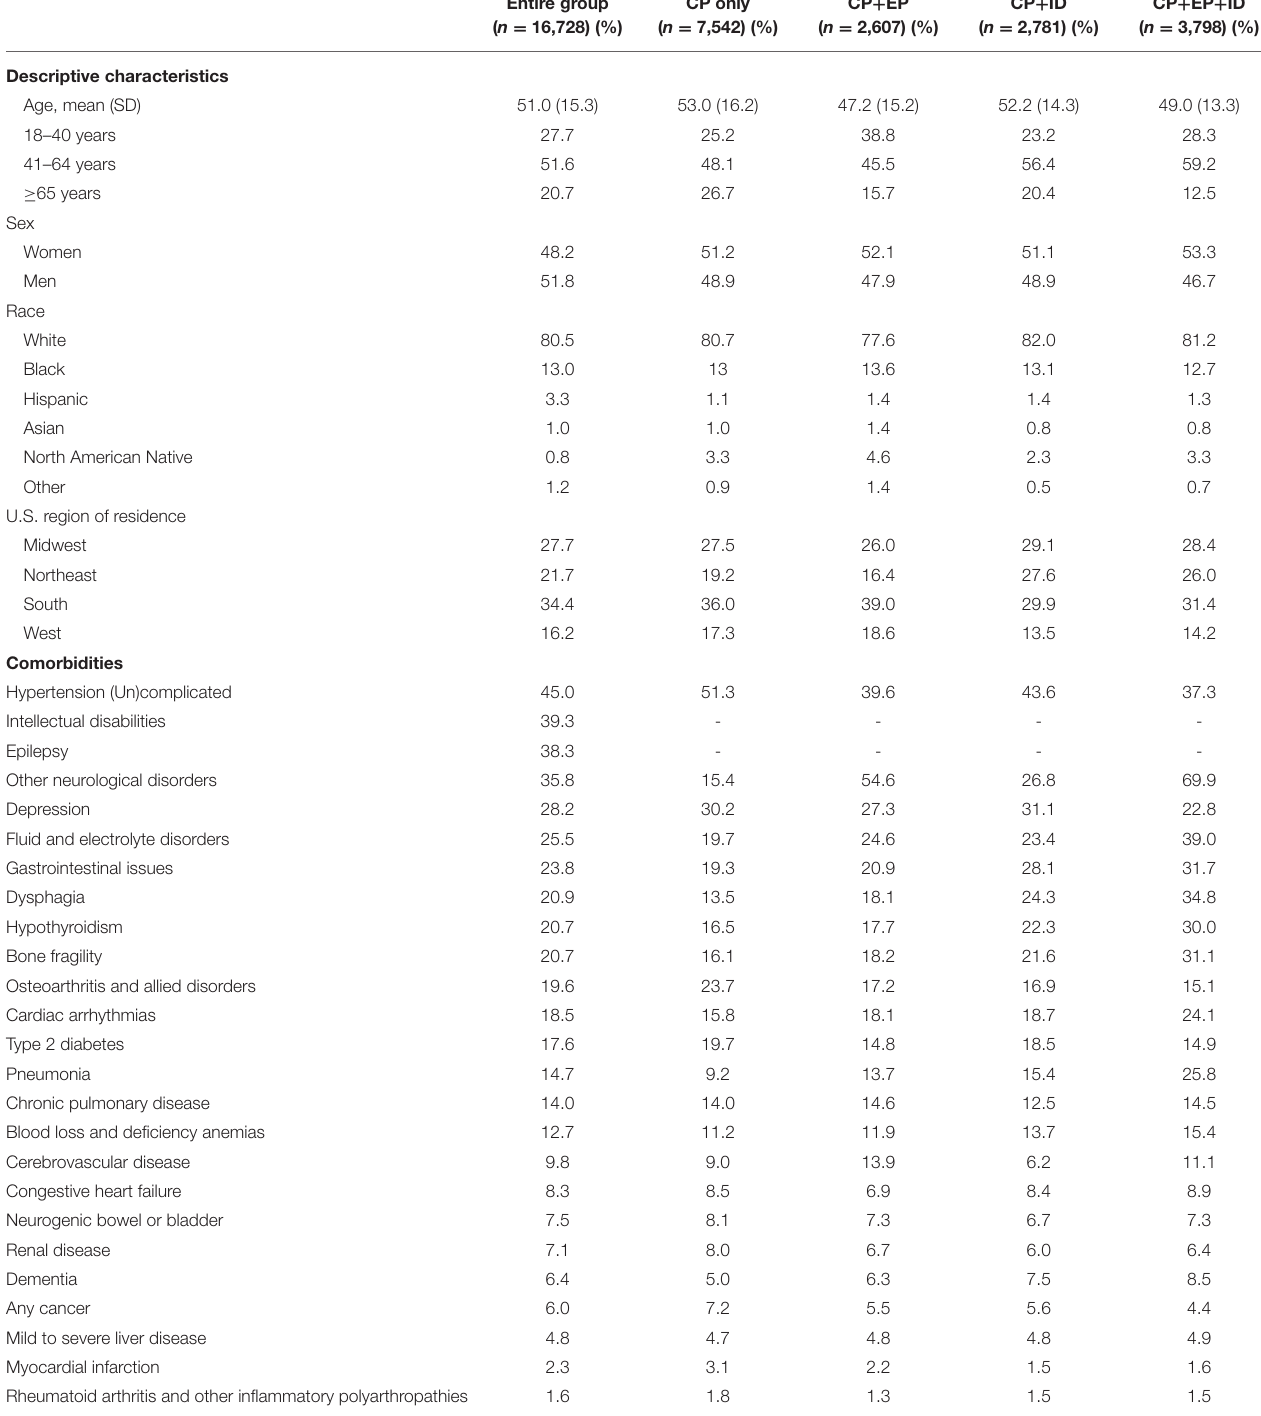
TABLE 1 | Baseline descriptive characteristics and prevalence of comorbidities for the entire group of adults with cerebral palsy (CP) and for mutually exclusive subgroups based on co-occurring epilepsy (EP) and intellectual disabilities (ID). Entire group ( n = 16,728)